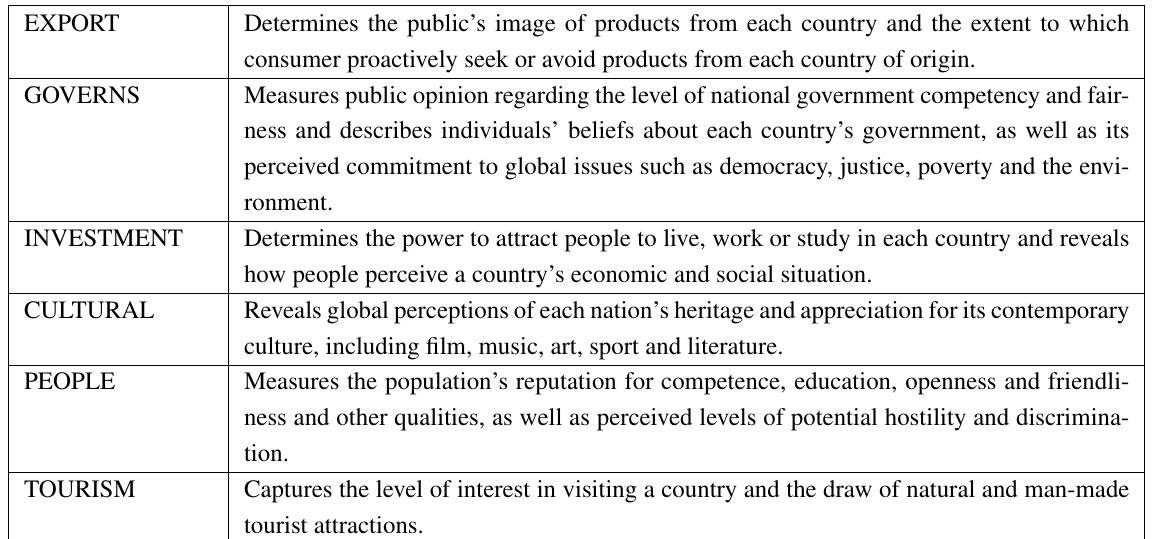
Table 1. Anholt GFK six Path